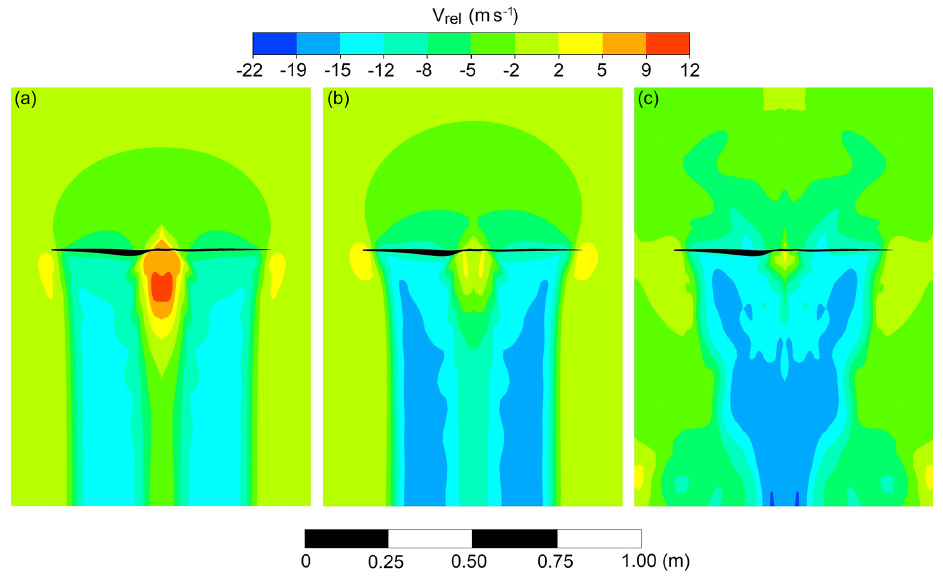
Figure 3. Simulation of the relative vertical flow velocity ( V rel ) induced by a propeller blade during hover (a) , vertical climb at a speed of 6.5ms − 1 (b) and descent at a speed of − 2.5ms − 1 (c) . Downward-pointing velocities have a negative